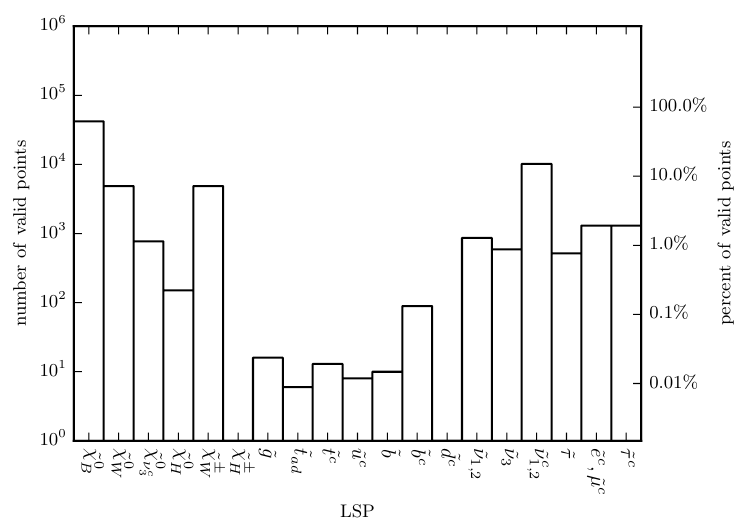
Figure 3. A histogram of the LSPs associated with a random scan of 100 million initial data points, showing the percentage of valid black points with a given LSP. Sparticles which did not appear as LSPs are omitted. The y-axis has a log scale. The notation and discussion of the sparticle symbols on the x-axis is presented in table